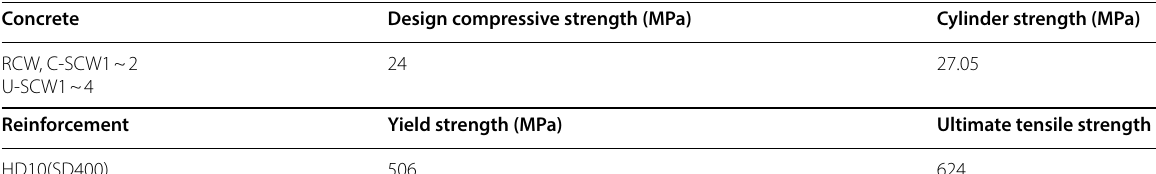
Table 4 Material properties of the specimens.